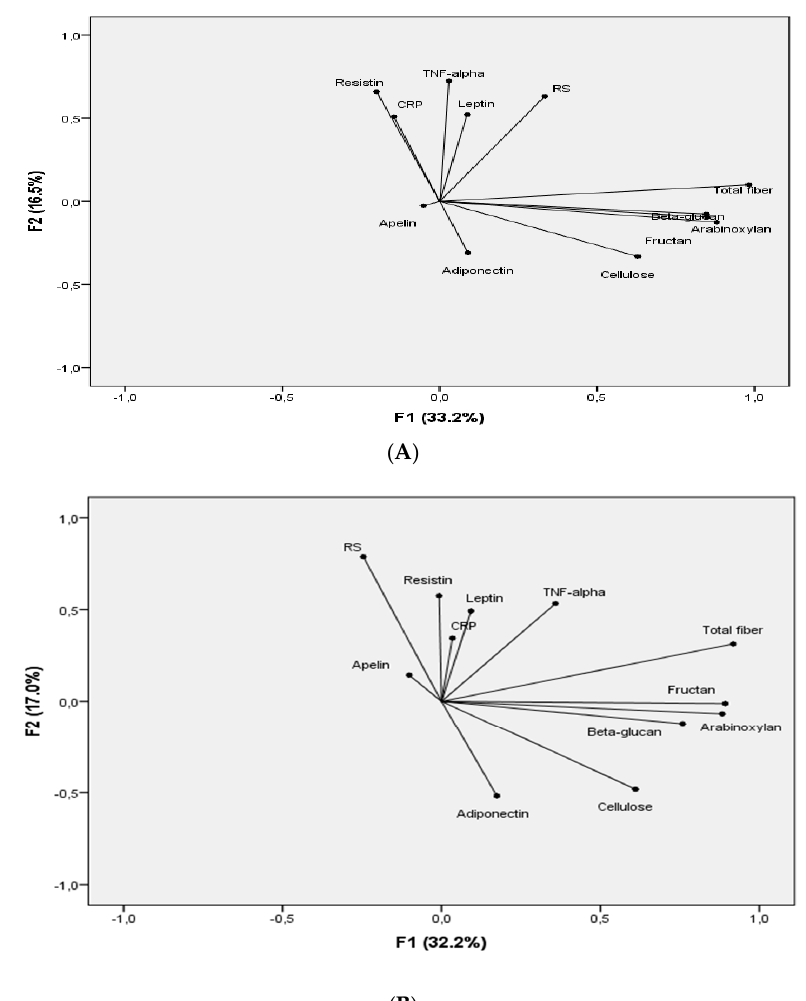
Figure 4. Principal Component Analysis for total fibre, fibre fractions (fructan, β -glucan, arabinoxylan, cellulose and resistant starch (RS) and adipocytokines content at the beginning ( A ) and after 12 months ( B ) of lifestyle intervention.